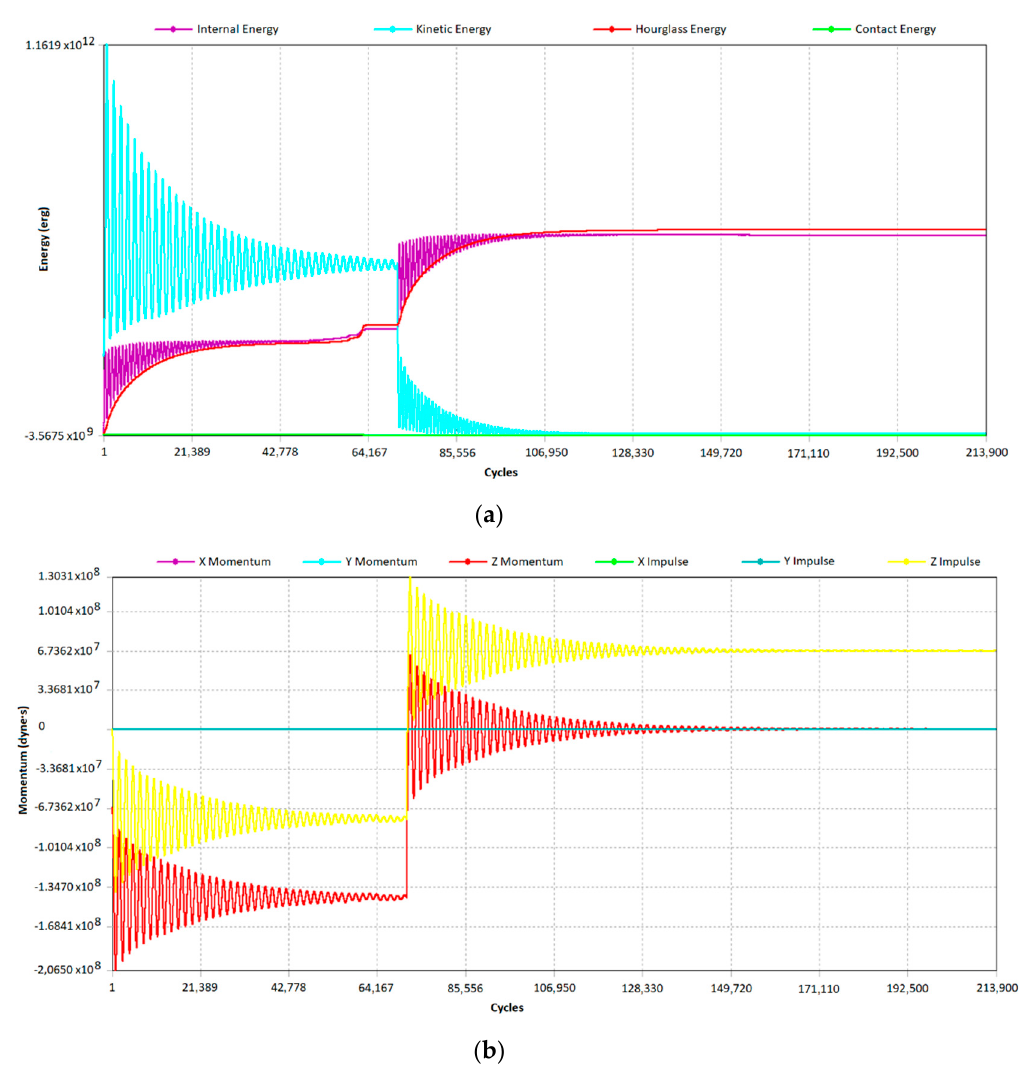
Figure 20. Tulip contact motion analysis charts: ( a ) Sum of energy—Variant II, and ( b ) torque value—Variant II.